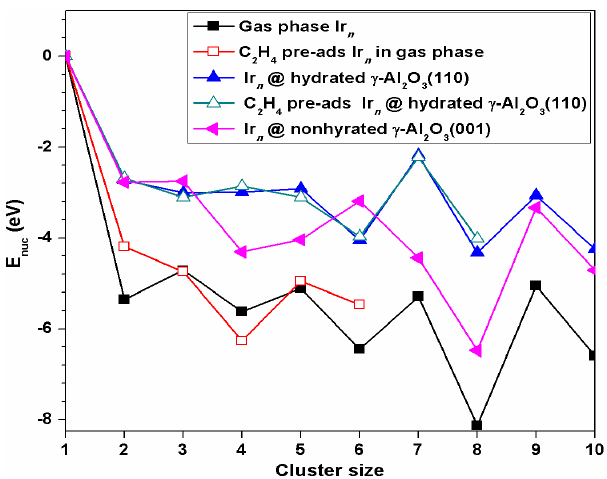
Figure 9. Nucleation energies E nuc of the gas-phase Ir n cluster; ethylene pre-adsorbed Ir n in the phase via the π mode; Ir n on hydrated γ -Al 2 O 3 (110); and ethylene pre-adsorbed at the interface of Ir n / γ -Al 2 O 3 (110). For comparison, nucleation energy for Ir n on γ -Al 2 O 3 (001) [13] is also included. An E nuc comparison between hydrated (110) and non-hydrated (001) γ -Al 2 O 3 surfaces revealed that except for Ir 3 and Ir 6 clusters, the nucleation of Ir n clusters were less favorable on the